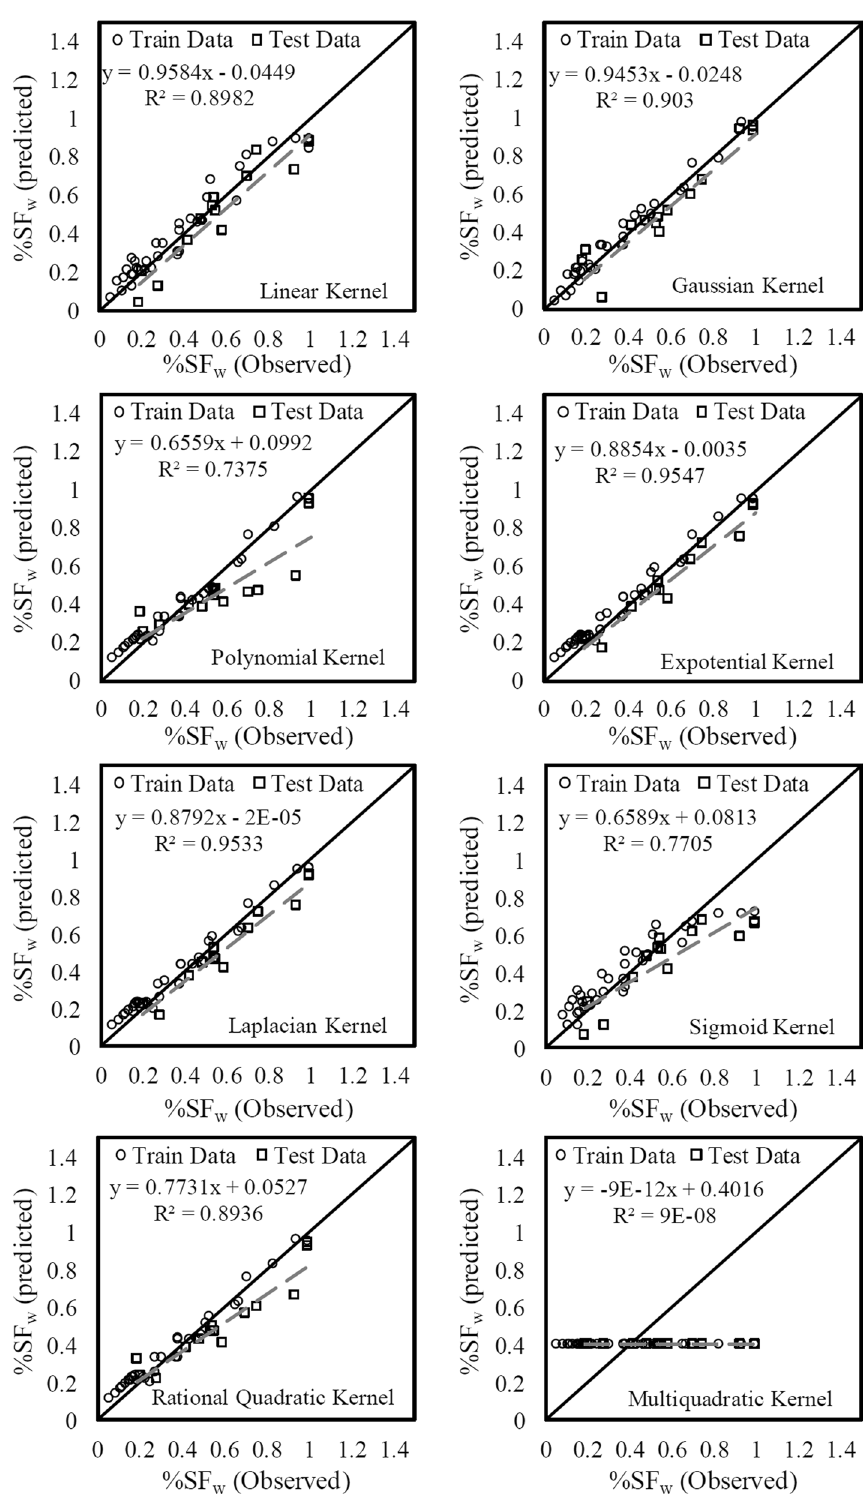
Fig. 1 Scatter plot of the SVR model with different kernel